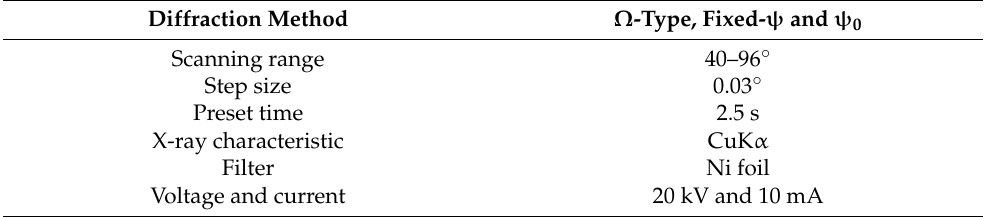
Table 6. XRD conditions in thickness measurement of nickel-coating layer.